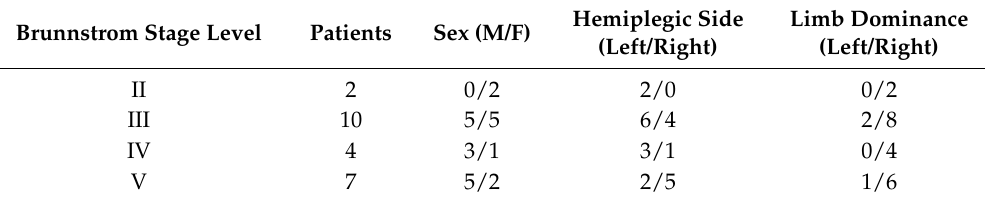
Table 2. The general information of the 23 stroke